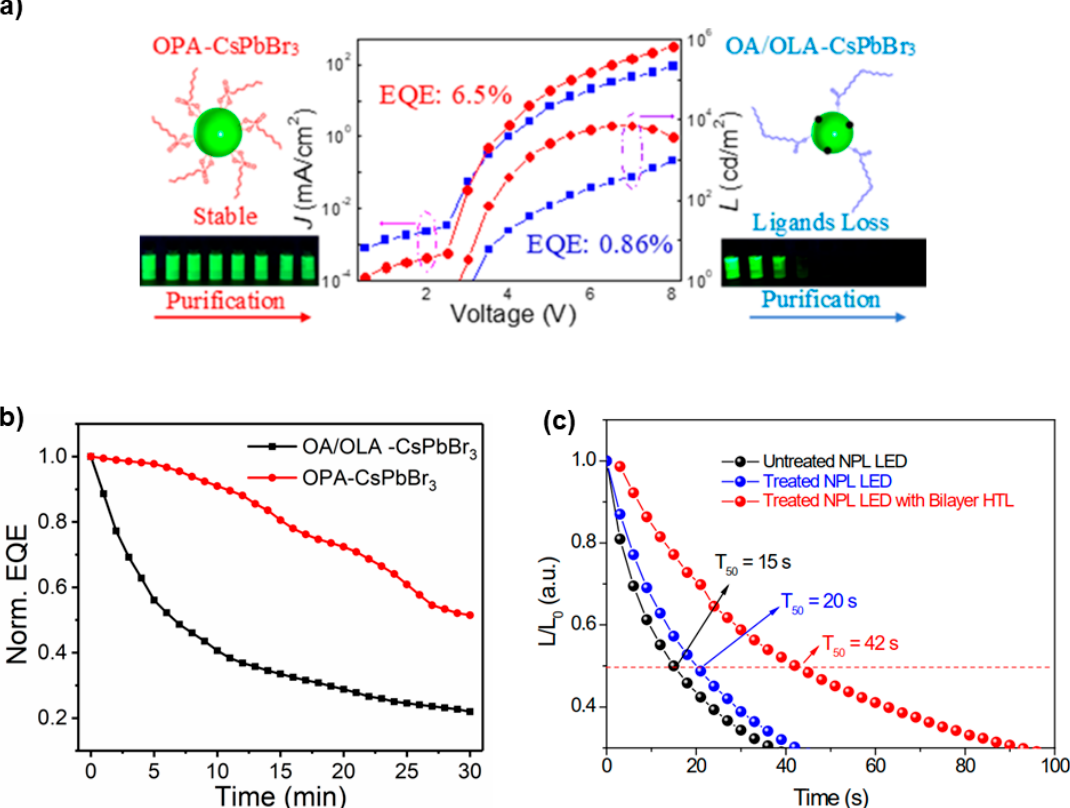
Figure 3. ( a ) Schematic illustration of the ligand treatment for high-performance PeLEDs. ( b ) Time-dependent EQE decay (under 2.5 mA cm − 2 ) of PeLEDs based on OPA-CsPbBr 3 and OA/OLA-CsPbBr 3 . Reproduced from reference [137] American Chemical Society, 2018. ( c ) Stabilities of PeLEDs with untreated nanoplatelet (NPL), treated NPL, and bilayer hole transport layer (HTL) (under 1 mA cm − 2 ). Reproduced from reference [138], American Chemical Society,